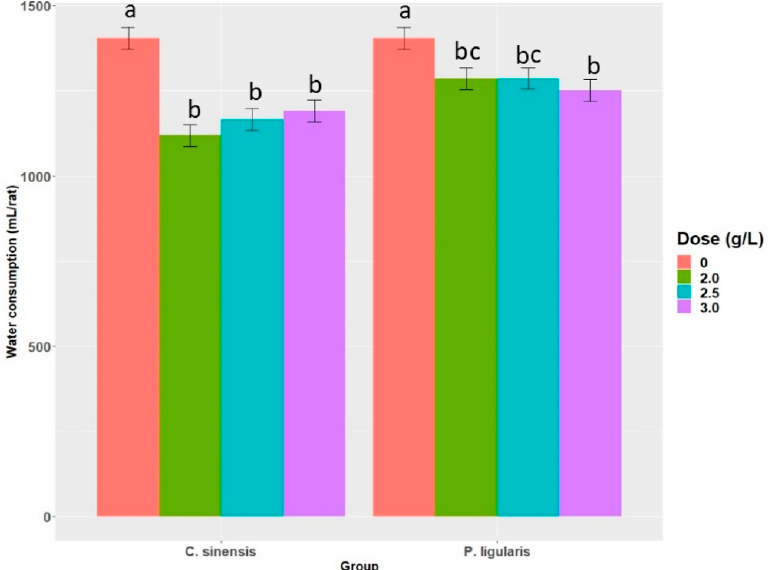
Figure 3. Total water consumption during the seven-week experimental period at different doses of supplementation with polyphenol-rich extracts. Data are means of volume (mL) consumed by animals in each group ( n = 4) ± standard deviations. Columns with different lowercase letters show statistically significant differences between them by the Duncan test ( p <